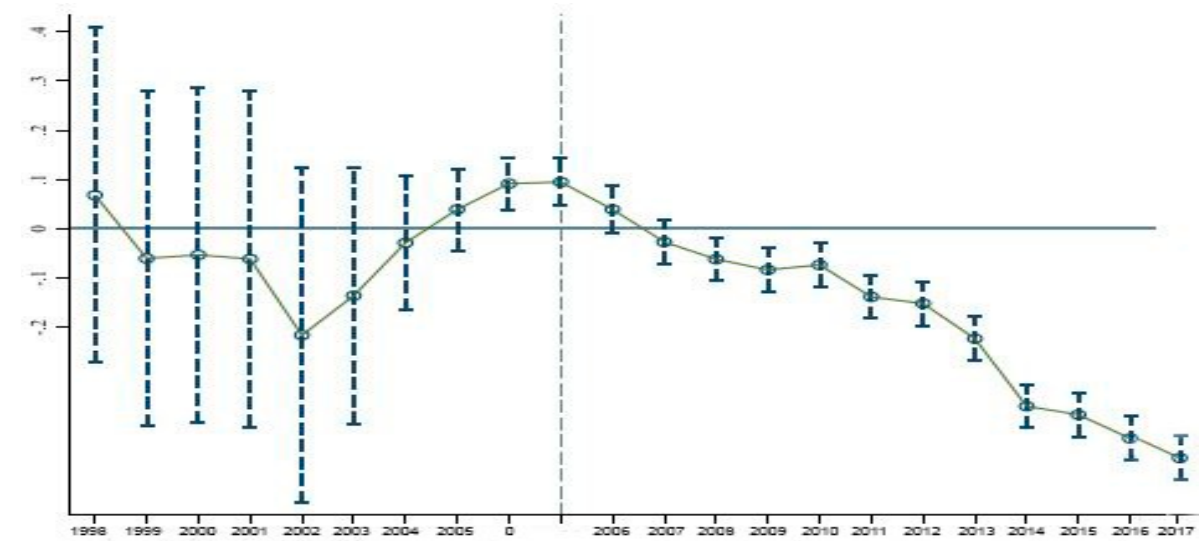
Figure 5. Robust results of fiscal decentralization role on climate change mitigation.